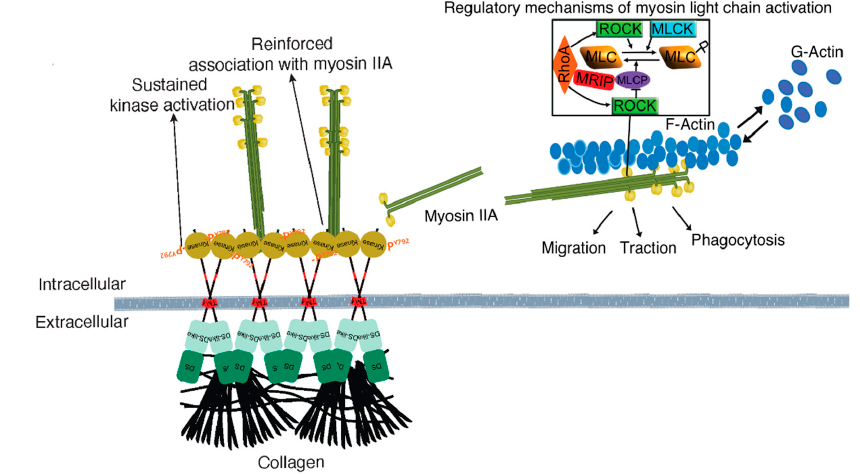
Figure 8. Mechanism of MRIP-dependent myosin IIA activity involved in DDR1 clustering and activation control collagen tractional remodeling. NMIIA filament assembly is mediated by myosin light chain kinase and ROCK, which enables DDR1-NMIIA association and force transmission to collagen [2]. DDR1 clustering and activation strengthen DDR1 binding to collagen and increase DDR1-NMIIA association and collagen tractional remodeling. Here we show that MRIP is a key regulator of the DDR1-NMIIA association. We show here that the association of DDR1 with NMIIA, the formation of DDR1 clusters, and the activation of DDR1 by autophosphorylation of Y792, requires MRIP. These processes ultimately determine the amplitude and kinetics of contractile force generation in the collagen-rich ECM.